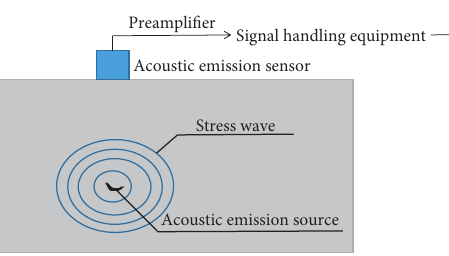
Figure 6: Change of normal component H memory signal in the stress concentration area.